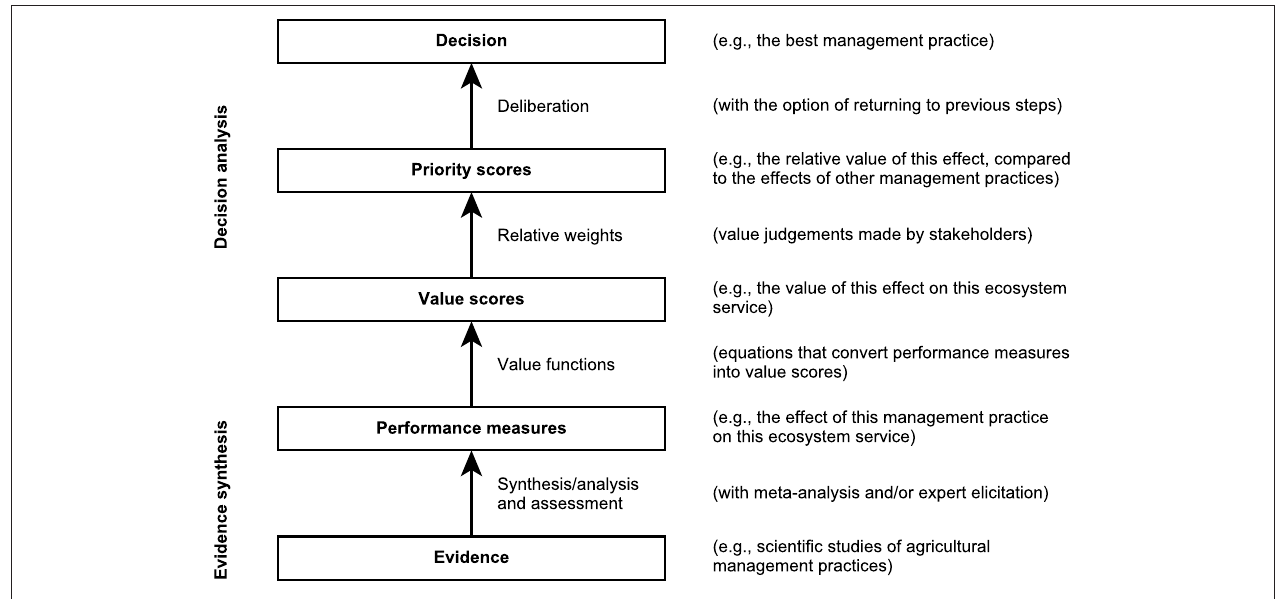
FIGURE 1 | A method of evidence-based decision